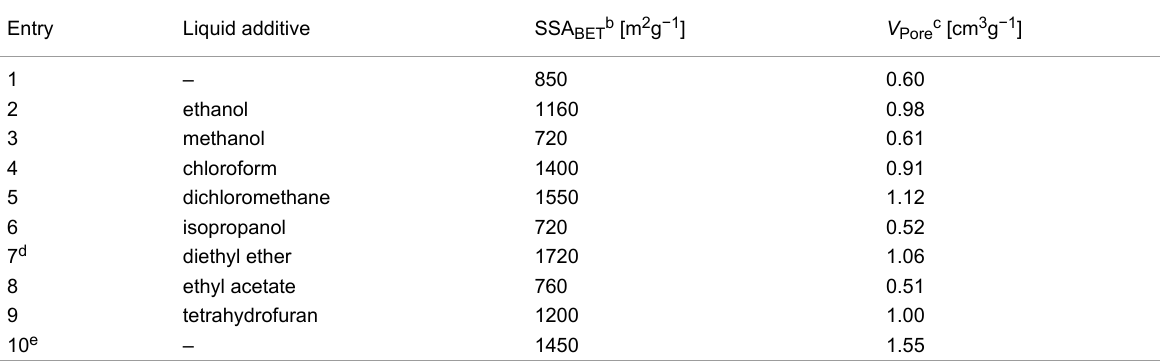
Table 1: Influence of the LAG additive on the textural properties of HCP a .